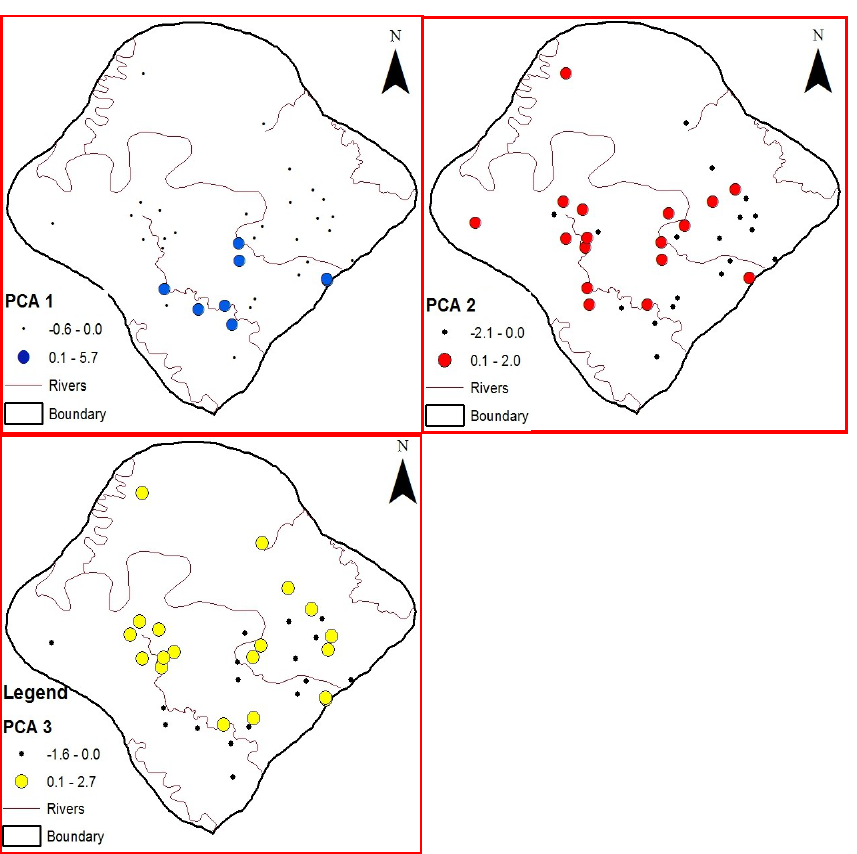
Figure 8. Spatial distribution of factor scores.